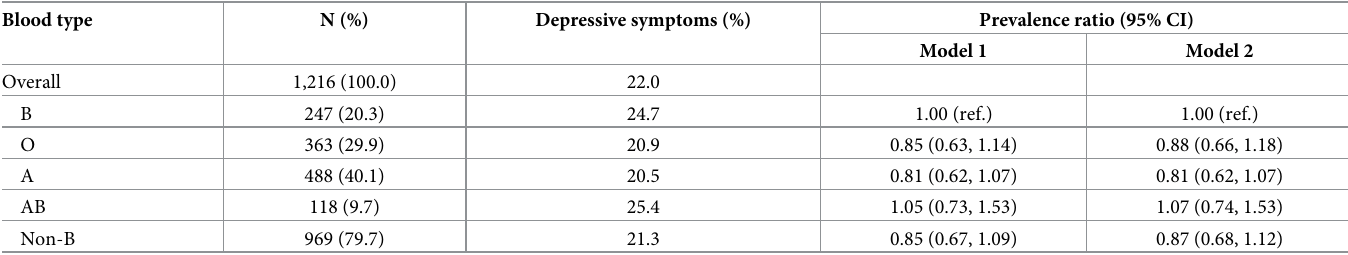
Table 2. Association of ABO blood types with depression